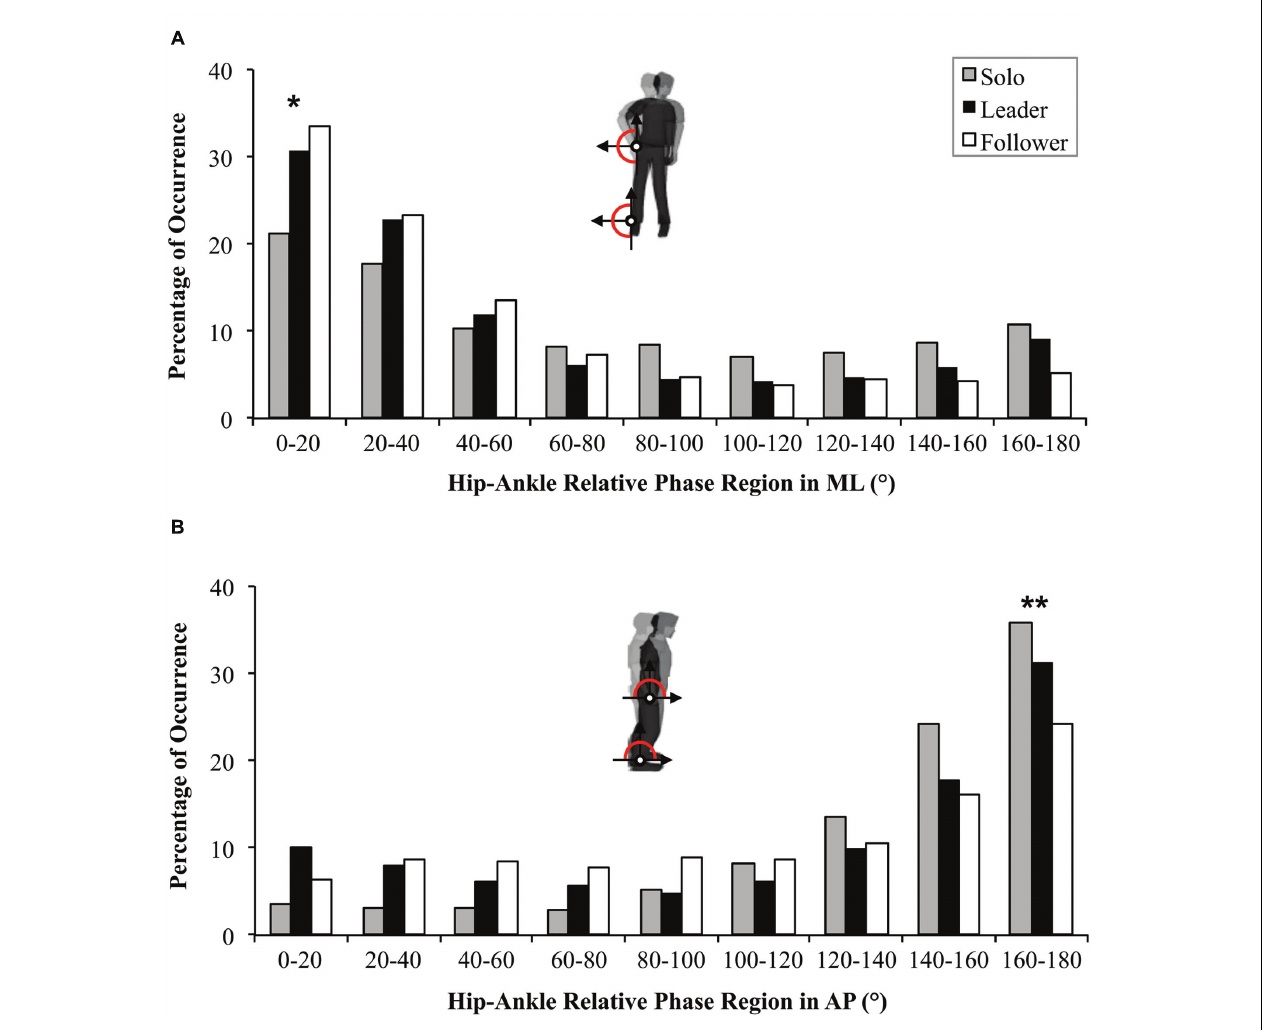
FIGURE 5 | Distribution of relative phase ( Ø h - a ) in ML (A) and in AP directions (B) between the Solo situation (gray) and Duo situations (Leader in black, Follower in white). Statistical differences between Solo and Duo situations (both Leader and Follower) are indicated by ∗ . Statistical differences between the three conditions (Solo, Leader and Follower) are indicated by ∗∗